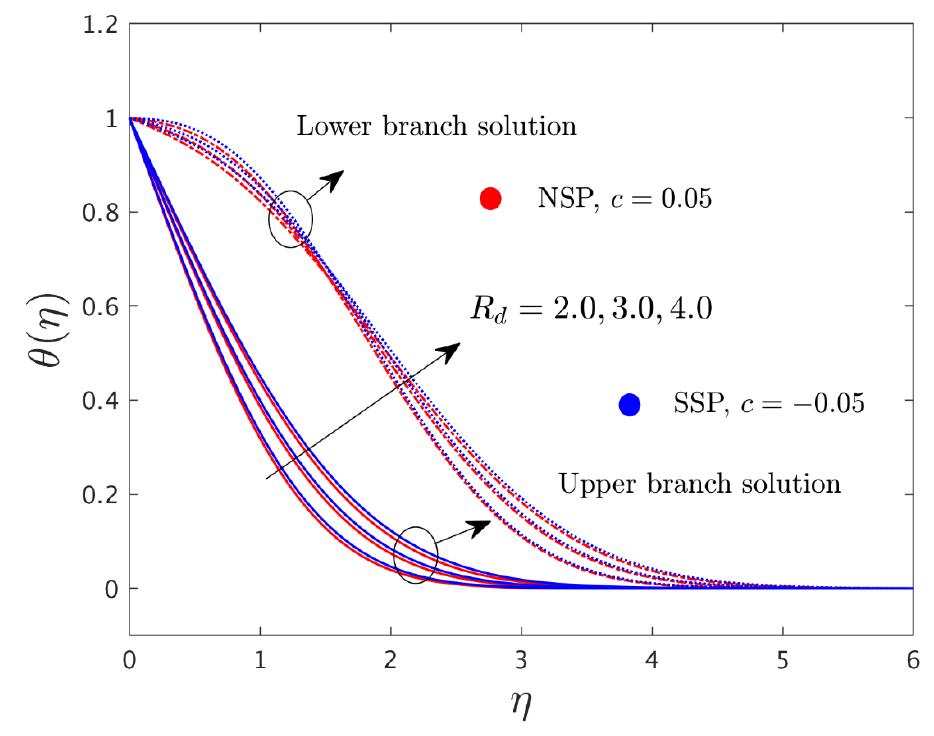
Figure 5. Temperature distribution profile θ ( η ) for varying R d